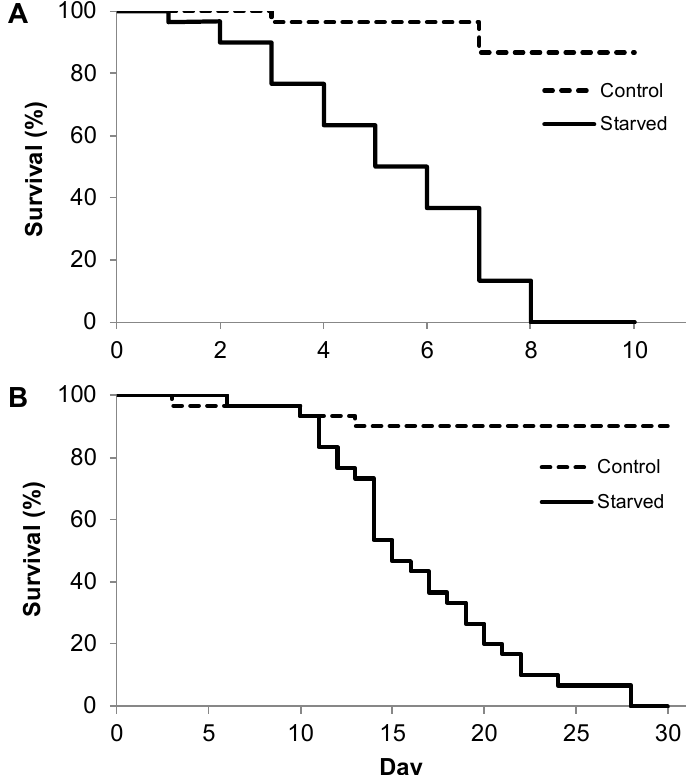
Figure 1. The survival analysis (log-rank test) of L1 (( A ); p < 0.0001) and L3 (( B ); p < 0.0001) pine-tree lappet Dendrolimus pini larvae for two variants of breeding, i.e., those fed ad libitum (control) and those without food